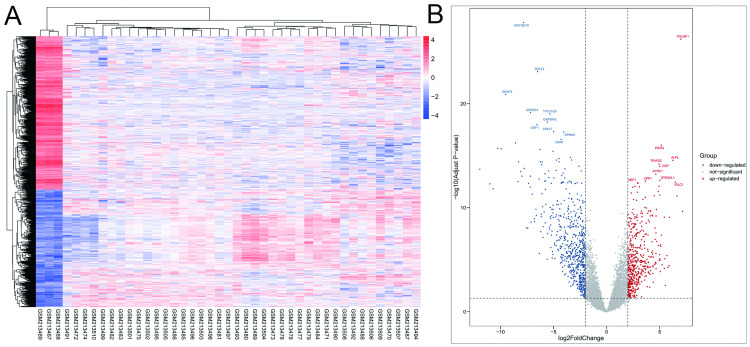
Identification of DEGs in GSE8607.(A) Heat map of the DEGs. (B) Volcano plot of the DEGs (cut-off criteria: adjust P-value < 0.01 and |logFC| ≥2).